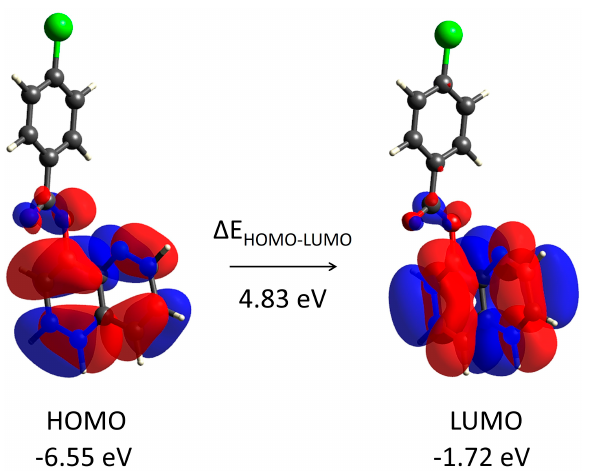
Figure 10. The crystallographic information files (.cif) of compound 3 were used to calculate its HOMO–LUMO energy levels with the B3LYP method and 6-31G(d,p) basis set.